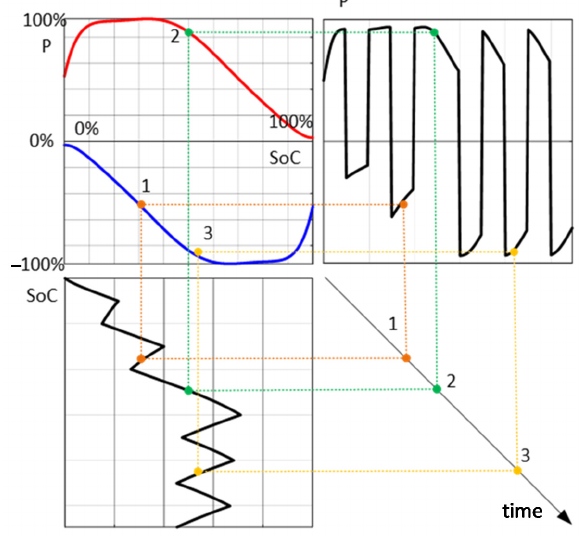
Figure 3. The scheme of determining points of BESS characteristics on the basis of current monitoring of storage operation. P—the power of charging and discharging the storage, SoC—state of charge. 3.3. Results of Short Term Tests for the Identification of the Actual Charging and Discharging Characteristics Based on the technical documentation of the BESS control and parameter monitoring systems, of BESS assumptions have been made about performing measurements of the examined storage. The characteristics were determined using samples measured at 1 min intervals, obtaining a set of points describing the characteristics. The measurements are shown in Figure 4.